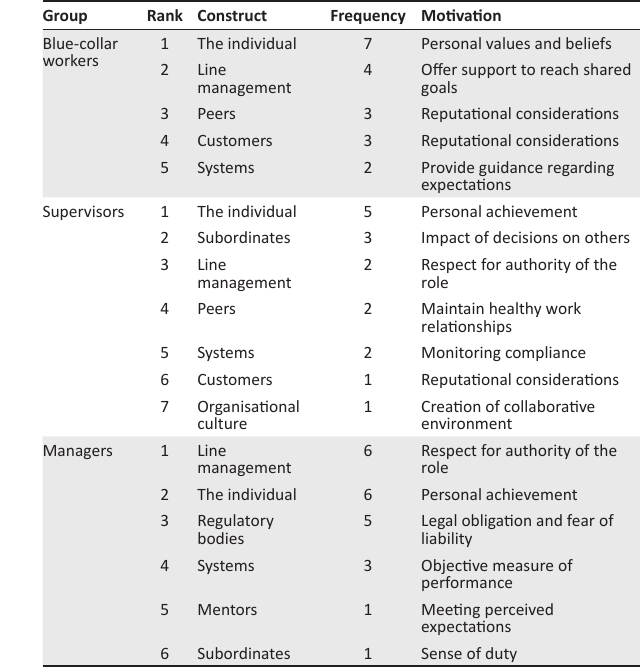
TABLE 5: Identified sources of accountability per subsample.